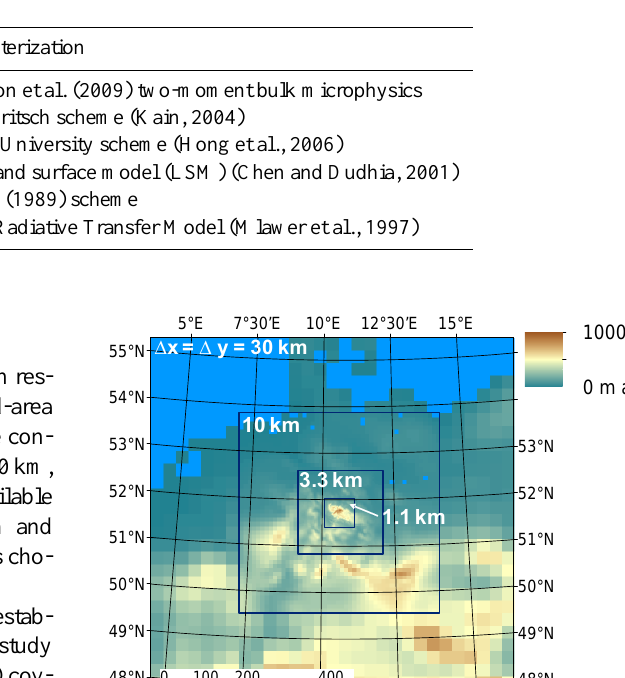
Table 1. WRF physics parameterization setup. Brief descriptions of the physics parameterizations are also given by Wang et al. (2012) and Skamarock et al. (2008).